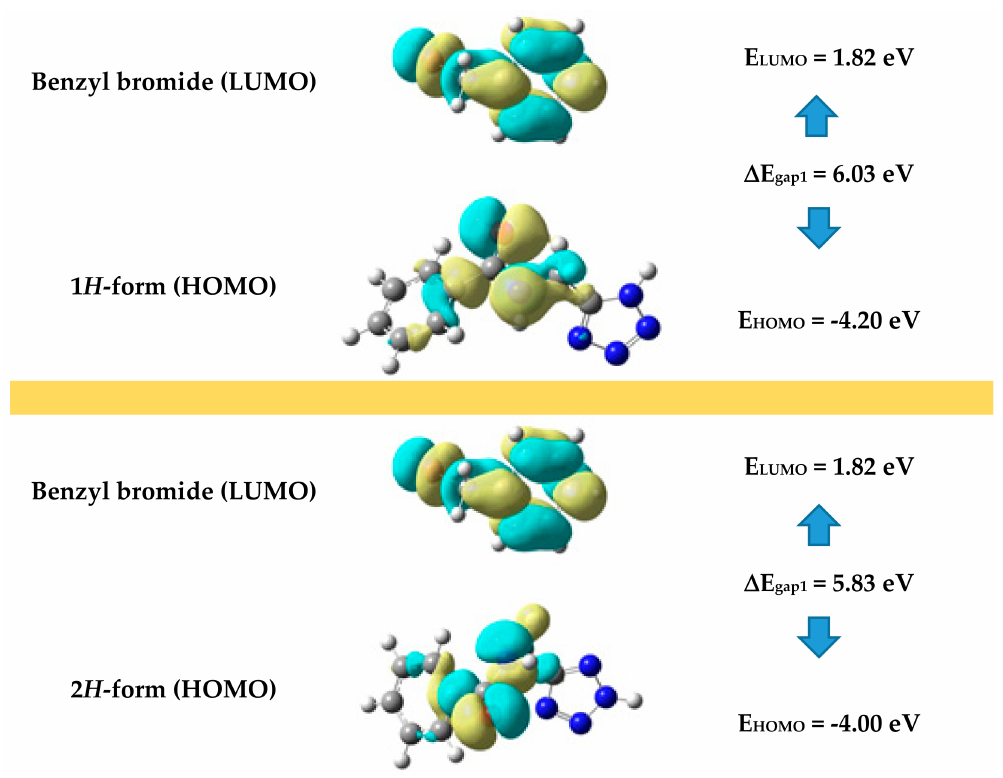
Figure 5. Energy gap between HOMO and LUMO of reagents in path